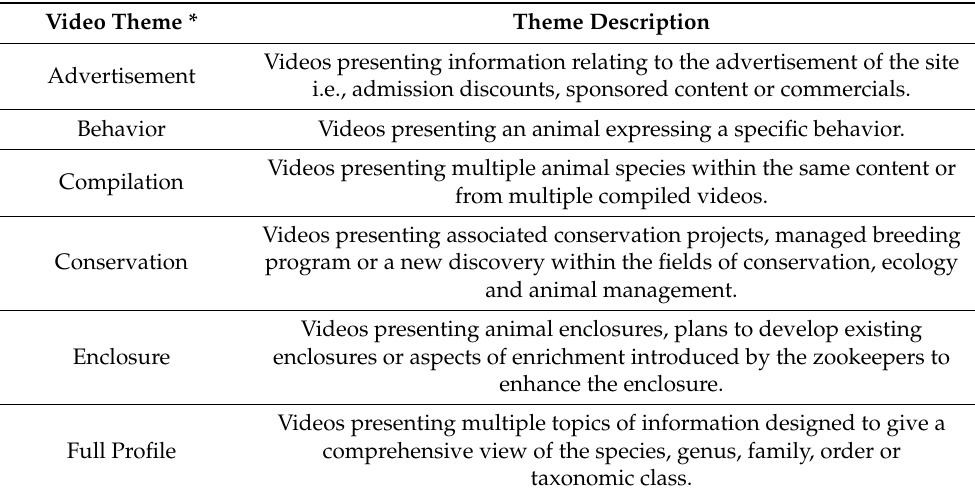
Table 2. Video themes presented within zoo-YouTube